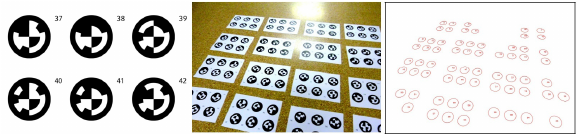
Figure 2: Fiducial markers, typical calibration image with printed marker sheets arranged on the planar surface of a floor and reli- ably detected markers with center position and